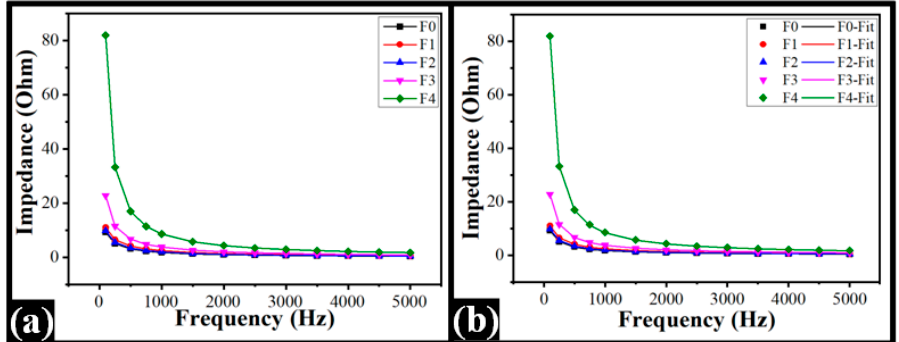
Figure 10. Electrical properties of the films: ( a ) Impedance profile and ( b ) model fitting (RQ(Q) of the impedance profile.